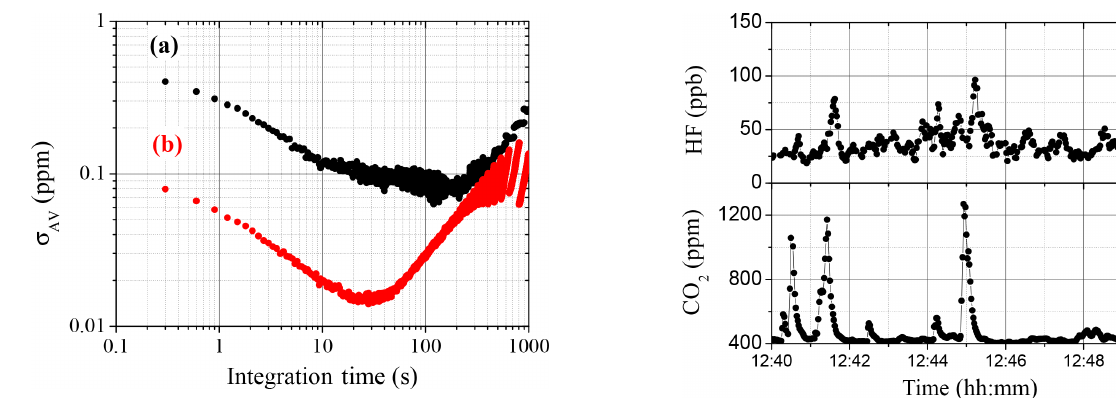
Figure 7. Time series of CO 2 and HF mixing ratios measured at the crater of Vulcano volcano on 22 April 2015, taken by the spectrom- eter in the closed-cell configuration. The measurements were car- ried out in an average condition of 990mbar of pressure and 300K of temperature. The integration time is 1.5s. The delay in the in- tegration times of the HF peaks with respect to the CO 2 peaks is due to chemisorption on instrument components in the closed cell configuration.